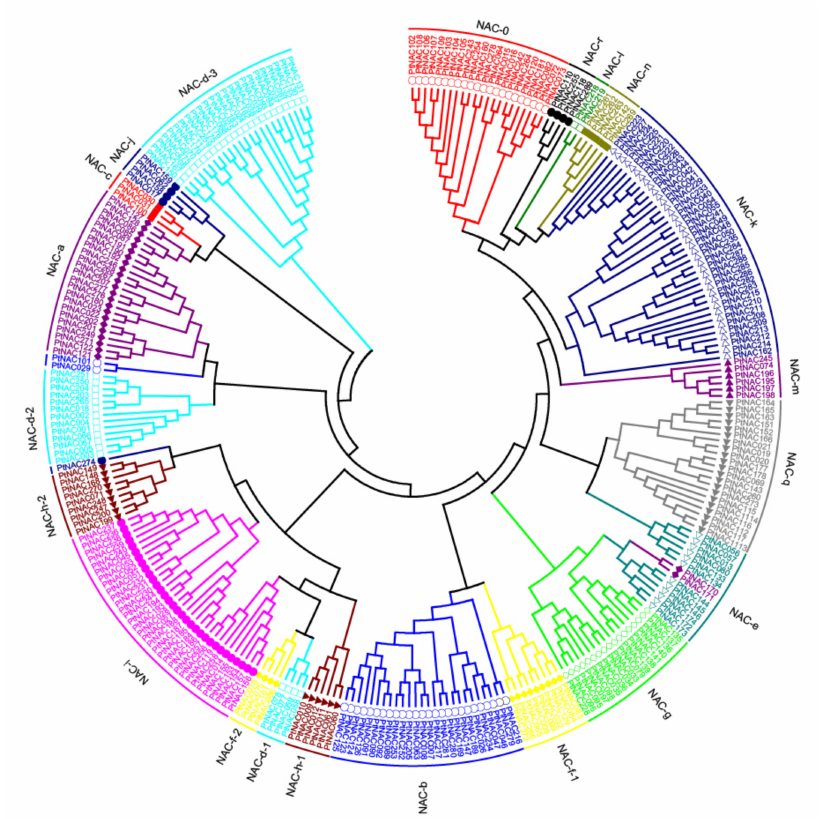
Figure 1. Multiple alignment and phylogenetic analysis of Populus NAC proteins. The full-length amino acid sequences of 289 Populus NAC proteins were aligned using Clustal X 1.83 and the phylogenetic tree was constructed using MEGA (Molecular Evolutionary Genetics Analysis) 7.0.21 with the NJ (Neighbor-Joining) method. Each subfamily is indicated in a specific